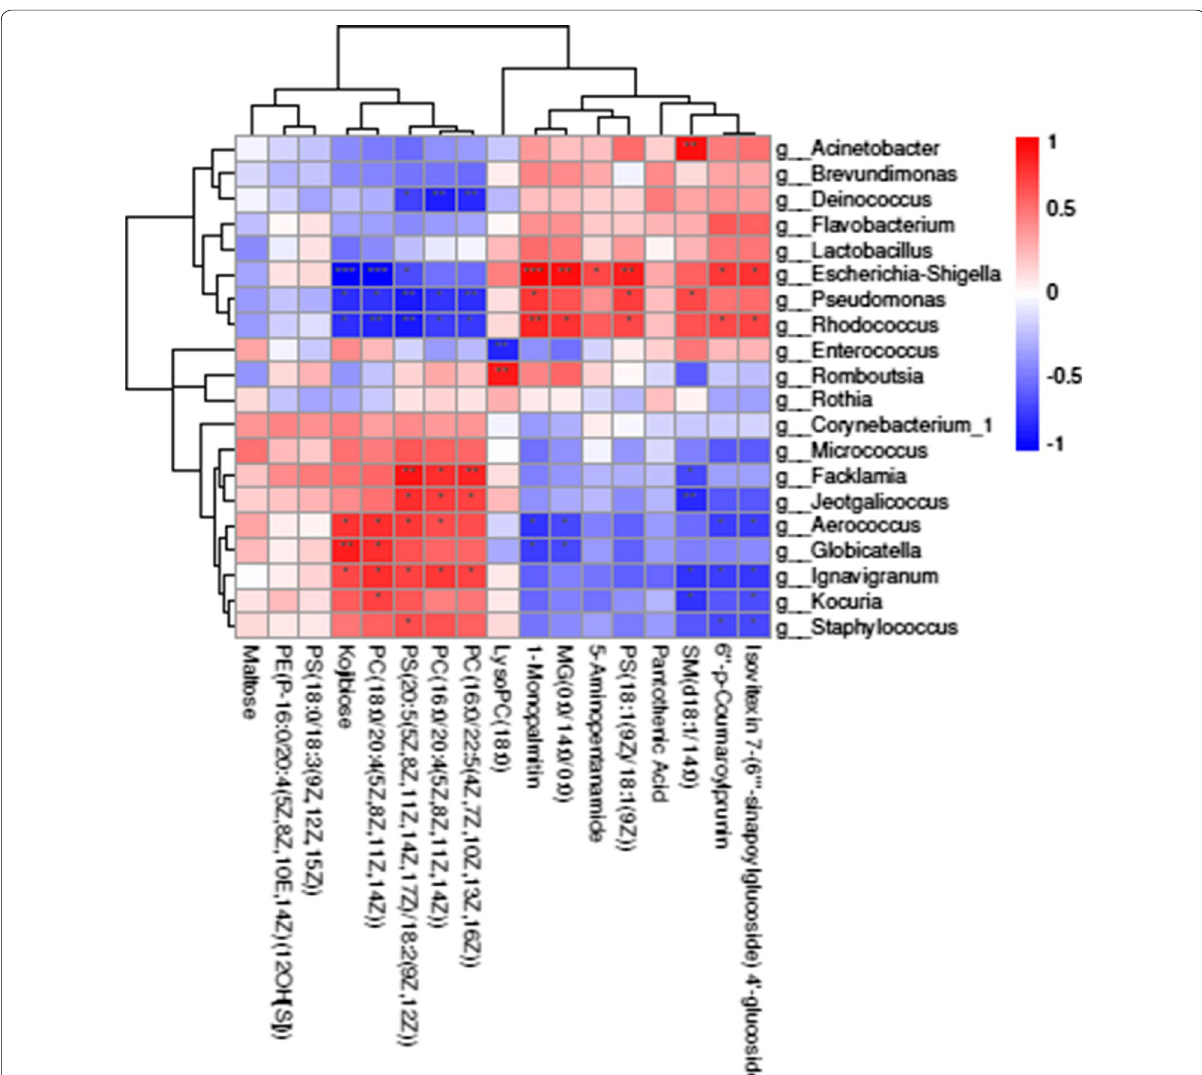
Fig. 6 Correlation analyses between bacterial genera and metabolites in the two treatments. (*0.01 < P < 0.05; **0.001 < P